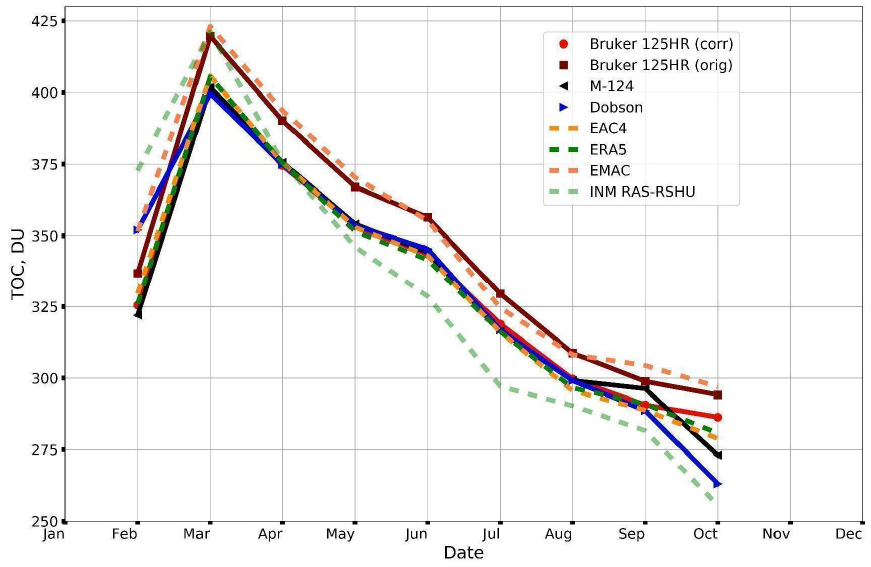
Figure 6. Seasonal variations in TOCs near St. Petersburg according to the ground-based observa- tions and simulated data in a 2009–2019 period. and simulated data in a 2009–2019